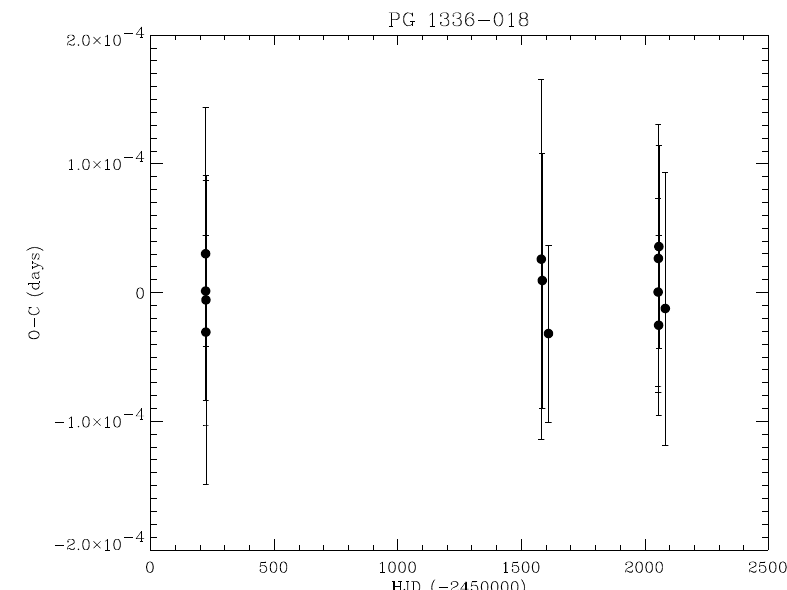
Fig. 2. The residuals between observed and calculated epochs of primary